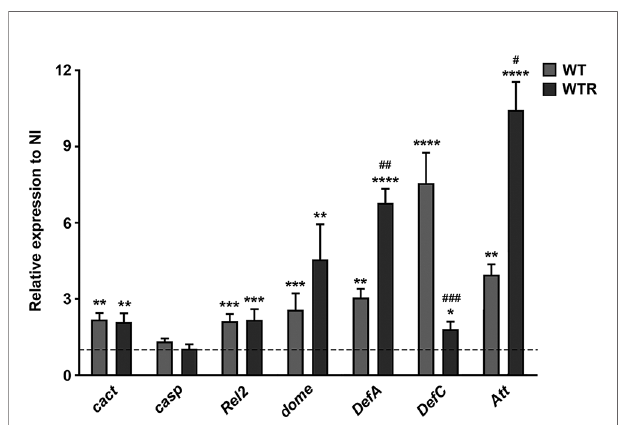
FIGURE 8 | Strigomonas culicis strains stimulated innate immune response, mainly by the Immune de fi ciency (IMD) and Janus kinase/signal transducer and activator of transcription (JAK – STAT) signaling pathways, during midgut infection. The transcript levels were evaluated in non-infected (NI), wild-type (WT) and hydrogen peroxide (H 2 O 2 )-resistant (WTR)- infected midguts 4 dpi. Gene expression was normalized using the transcript levels of the NI group (dashed line). Ribosomal protein S7 was used as an endogenous control. Signi fi cant p-values were obtained by Mann – Whitney test comparing NI and S. culicis -infected groups (*p = 0.02, **p = 0.003, ***p = 0.002, ****p = 0.001) or WT- and WTR-infected groups ( # p = 0.02, ## p = 0.01, ### p = 0.002), and error bars represent the mean ± SEM of three independent